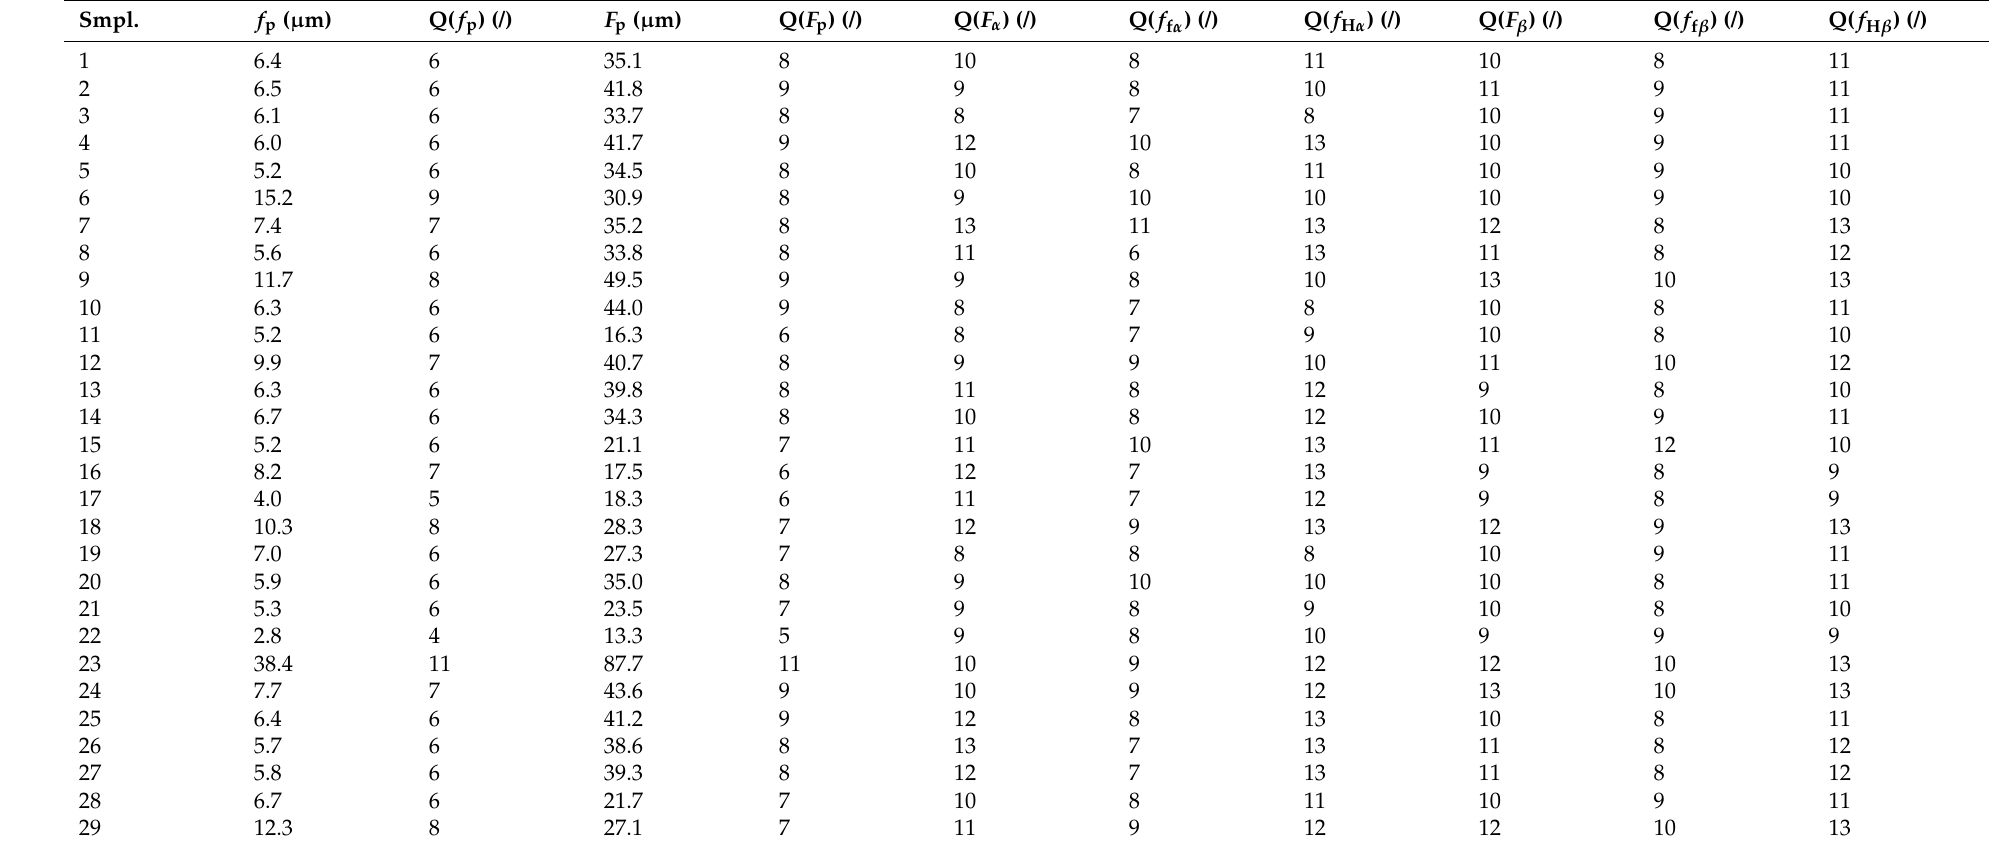
Table A1. Results of the evaluation of standard parameters for gear metrology. The results for the parameters are shown for the left flank.